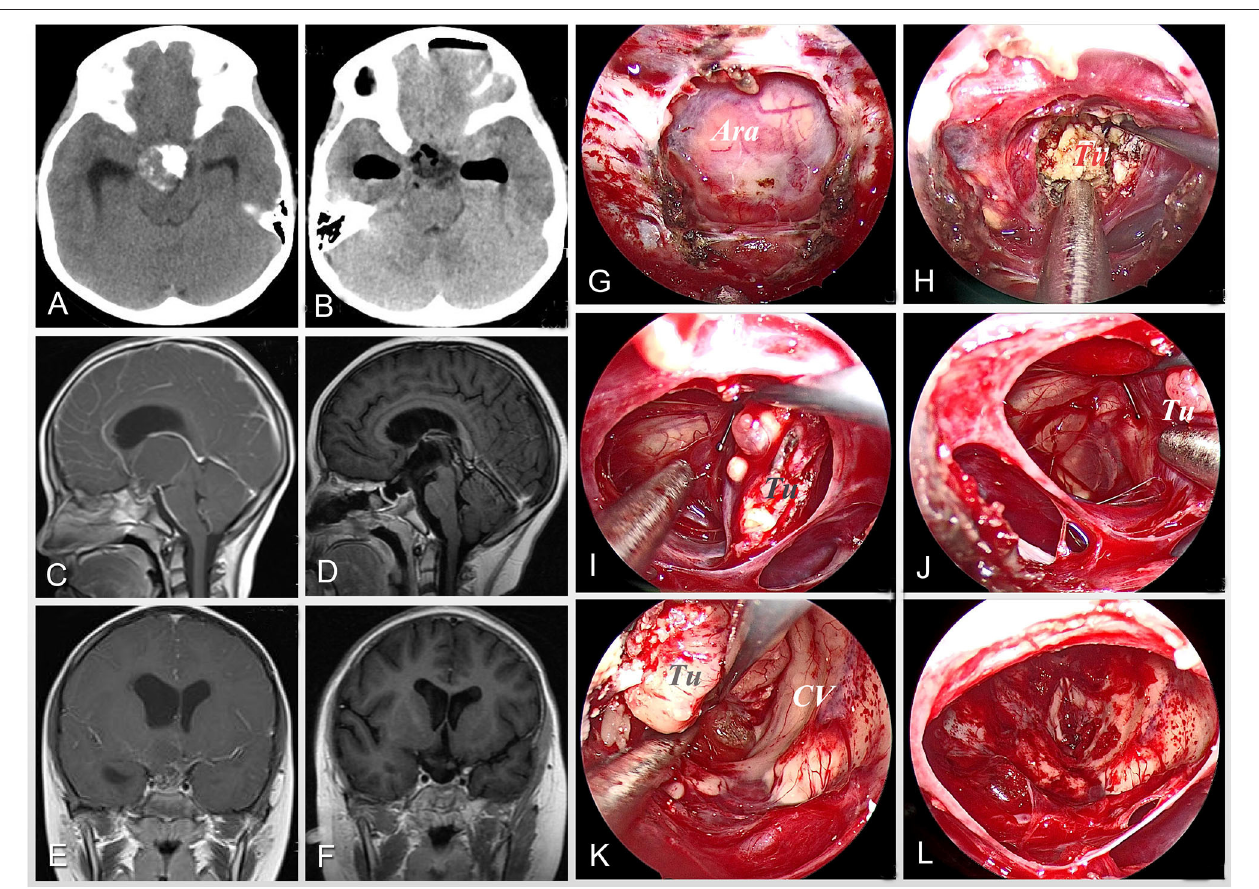
FIGURE 2 | Case 6 was an 8-year-old girl who complained of polyuria, impaired vision, headache, and vomiting on admission. Preoperative images of CT scan (A) and MRI scan (C,E) show a solid-cystic lesion with obvious calcification, involving the third ventricle with obstructive hydrocephalus. After careful preoperative evaluation, the extended neuroendoscopic endonasal approach was planned for the patient. The intraoperative pictures (G–L) illustrate the surgical procedures including exposing the bone window (G) , decompressing the tumor by sucking in the intratumor fluid oil (H) , separating the tumor along its boundary (I,J) and the third ventricular wall (K) , and gross-totally removing the tumor (L) . Postoperative imaging of CT (B) and MRI (D,F) demonstrates the complete resection of tumor and relief of hydrocephalus. Tu, tumor; Ara, arachnoid mater; CV, cerebral